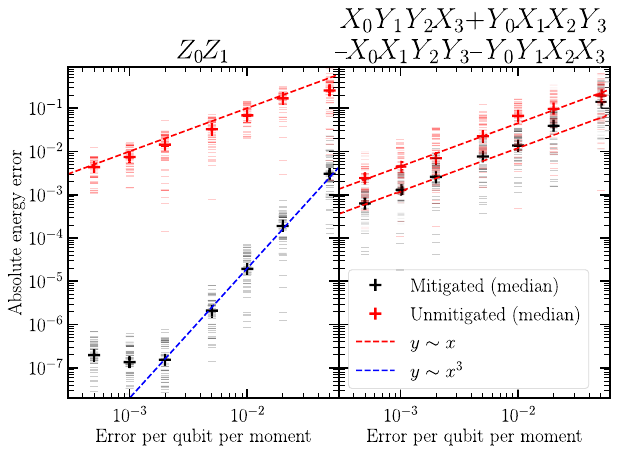
FIG. 11. Expectation value estimation of two individual H s terms from the control-free number-conserving Pauli operator decomposition of the H 2 Hamiltonian studied in Fig. 6 of the main text on states prepared by a fermionic swap network. The two terms here comprise part of the sum [Eq. (6) of the main text] for the expectation value of Fig. 6(b2) of the main text—but are studied here without prefactors (i.e., (cid:19) H s (cid:19) = 1). Each figure is labeled with the studied term, and guide lines (dashed red and blue) are given to show observed scaling laws. Data presented are the median (crosses) over 50 individual data points (faint dashes) of the absolute error in estimation using VPE (black) and standard partial state tomography